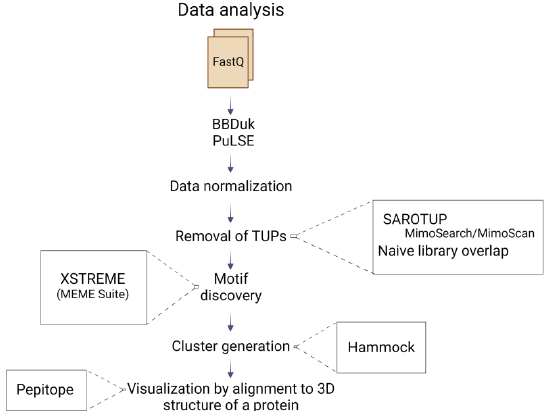
Figure 1. Schematic representation of protein–peptide interaction identification protocol. Created with BioRender.com.